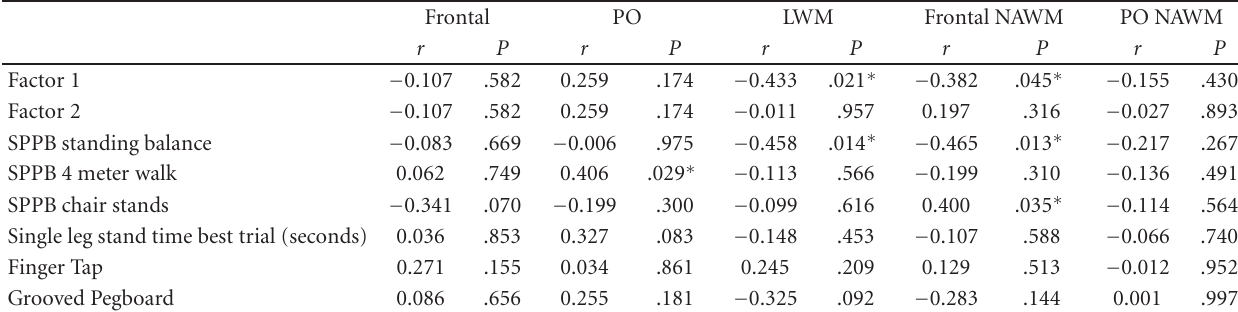
Table 3: Correlations between imaging data and motor performance tests, controlling for